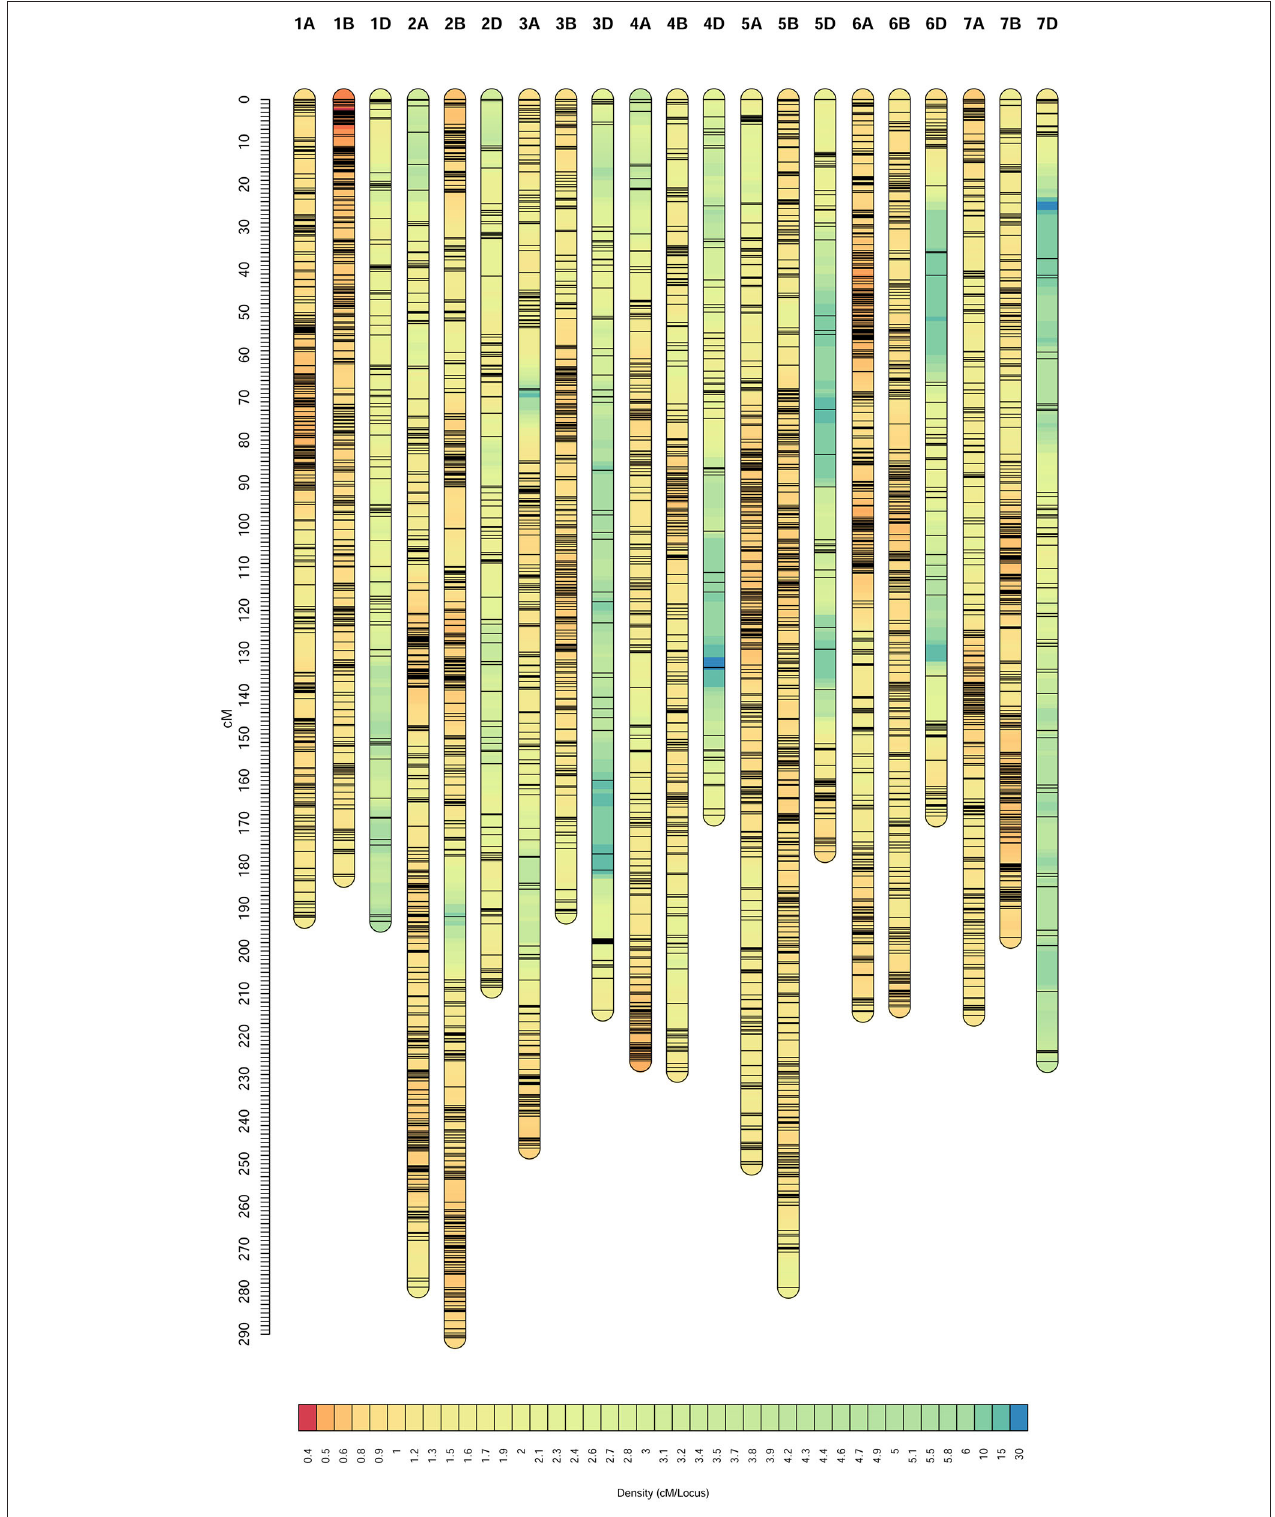
FIGURE 1 | Consensus genetic map constructed from the three recombinant inbred line (RIL) populations, Doumai × Shi 4185 (DS), Gaocheng 8901 × Zhoumai 16 (GZ), and Zhou 8425B × Chinese Spring (ZC).